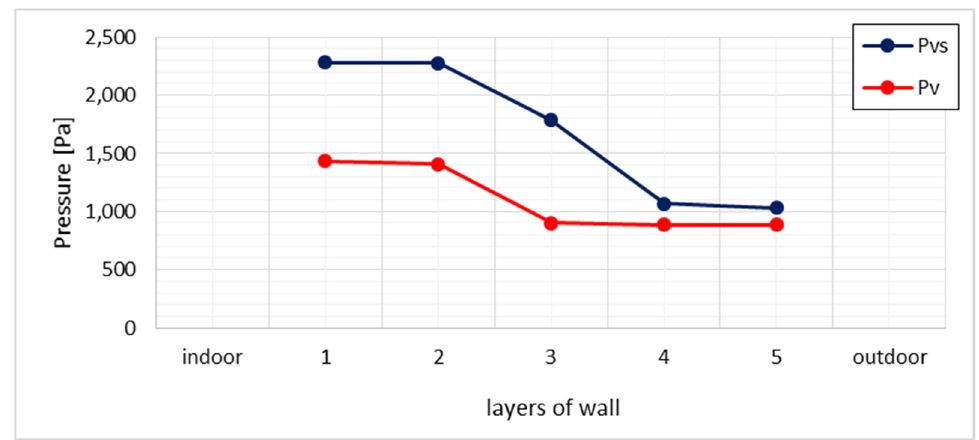
Figure 5. Glaser diagram: trend of saturation and vapour pressures throughout wall 2.